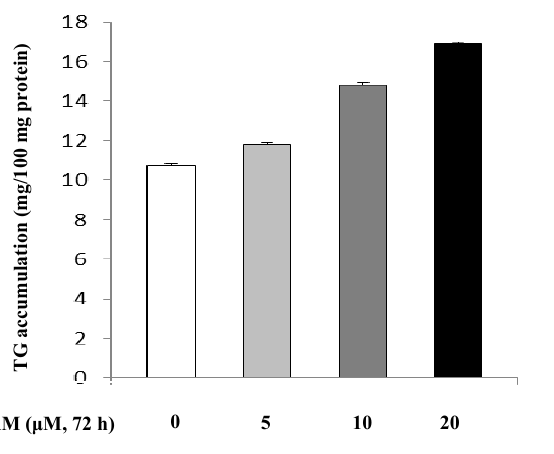
Figure 2. The effect of increasing concentrations of TAM on triglyceride (TG) accumulation in HepG2 cells. Hepatocytes were incubated with 0, 5, 10 and 20 μM of TAM for 72 h, respectively, and then collected for TG measurement. TG concentration was normalized with protein content. Experimental procedures are shown in the Materials and Methods section. Data are expressed as the means ± SD ( n =